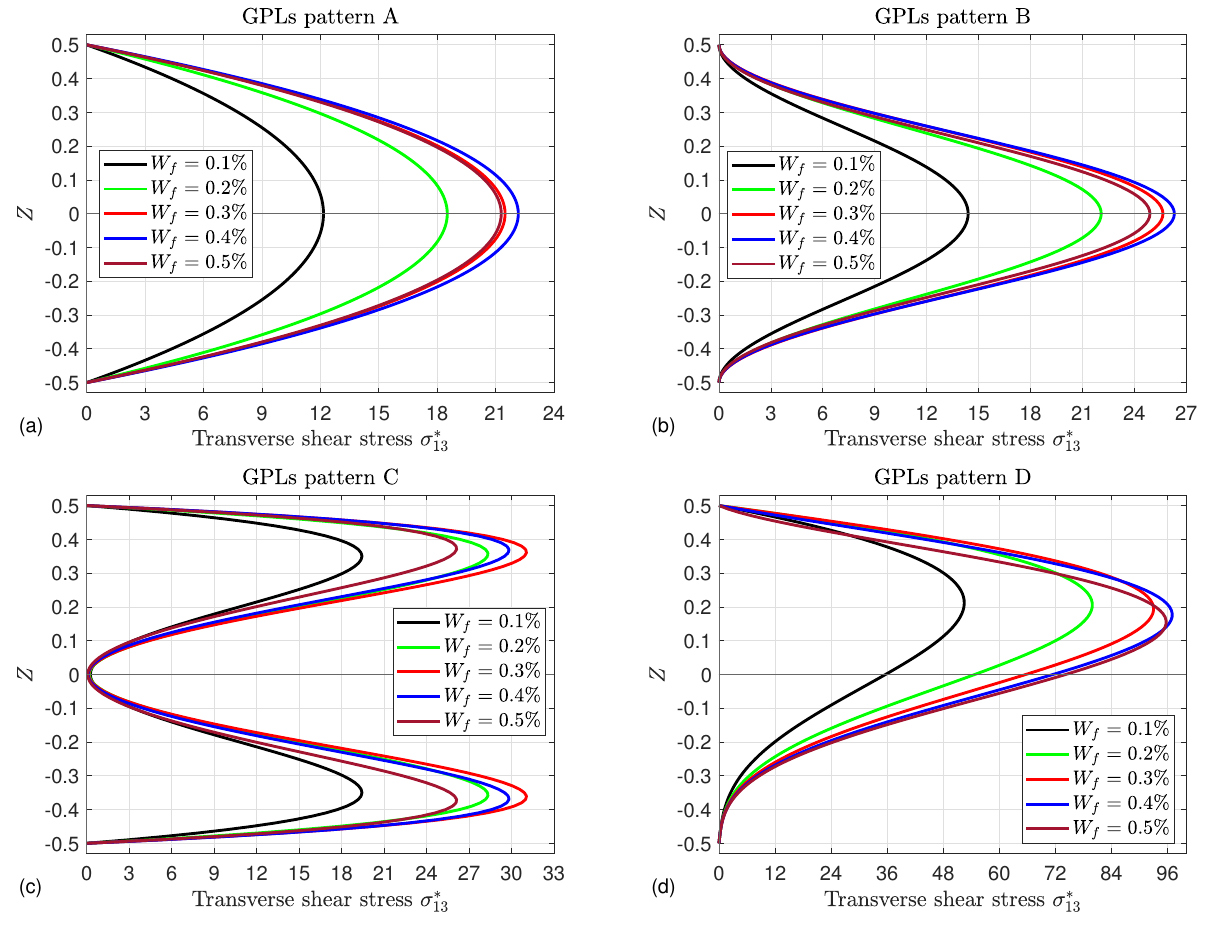
in FG porous 13